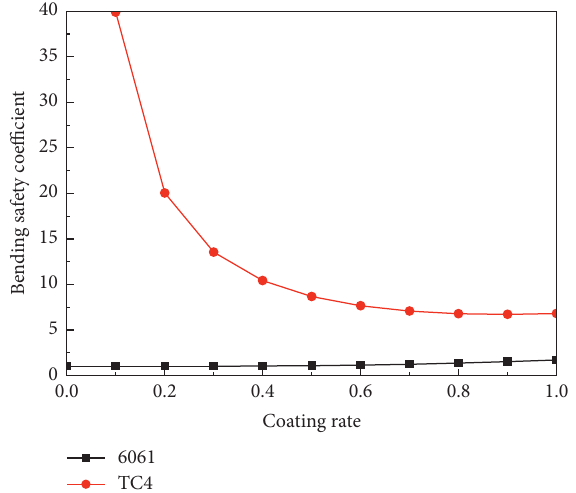
Figure 4: The bending safety coefficient.